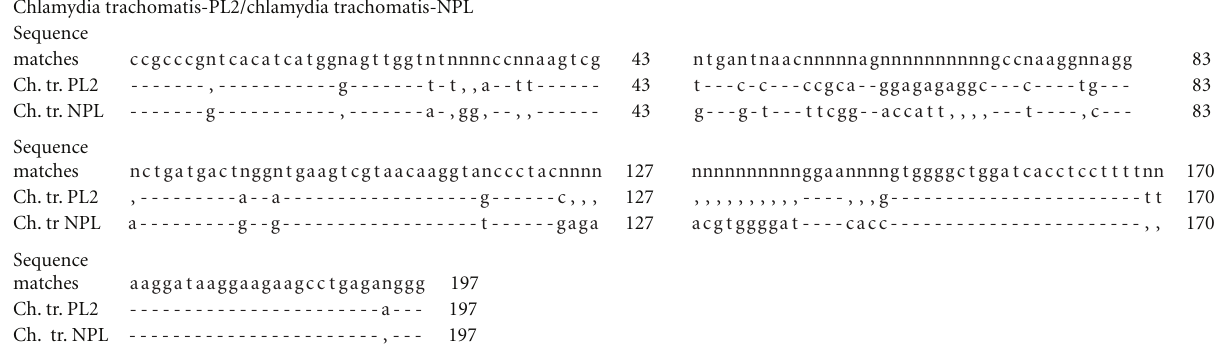
Figure 5: Comparative analysis of 16S–23S nucleotide sequence clusters of the middle ribosomal cluster and 23S rRNA I domain of nonplasmid (NPL) Chlamydia trachomatis strains released from monkeys and plasmid (PL2) Chlamydia trachomatis strains released from humans. ( - )—match of nucleotides in the sequence, (n)—mismatch of nucleotides in the sequence, (,)—absence of nucleotides in the sequence, (43-197)—nucleotide sequence